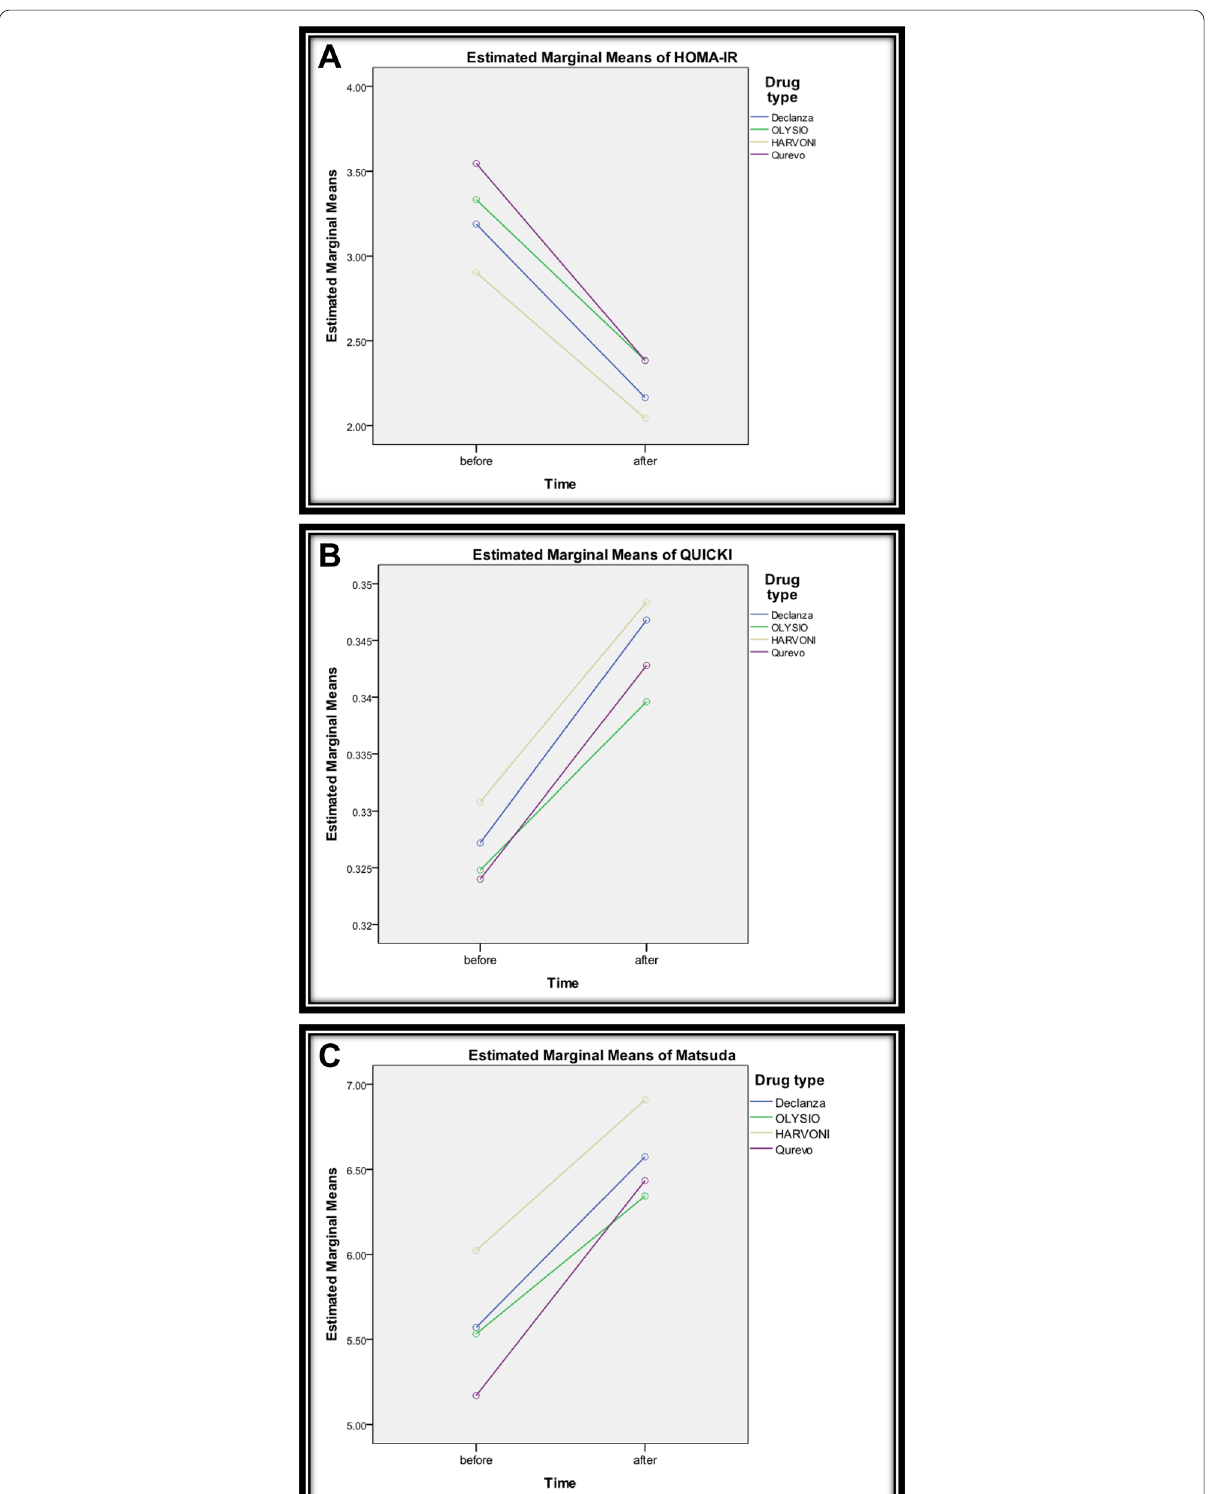
Fig. 6 A Estimated marginal mean values of HOMA‑IR over time between the four groups. B Estimated marginal mean values of QUICKI over time between the four groups. C Estimated marginal mean values of Matsuda index over time between the four